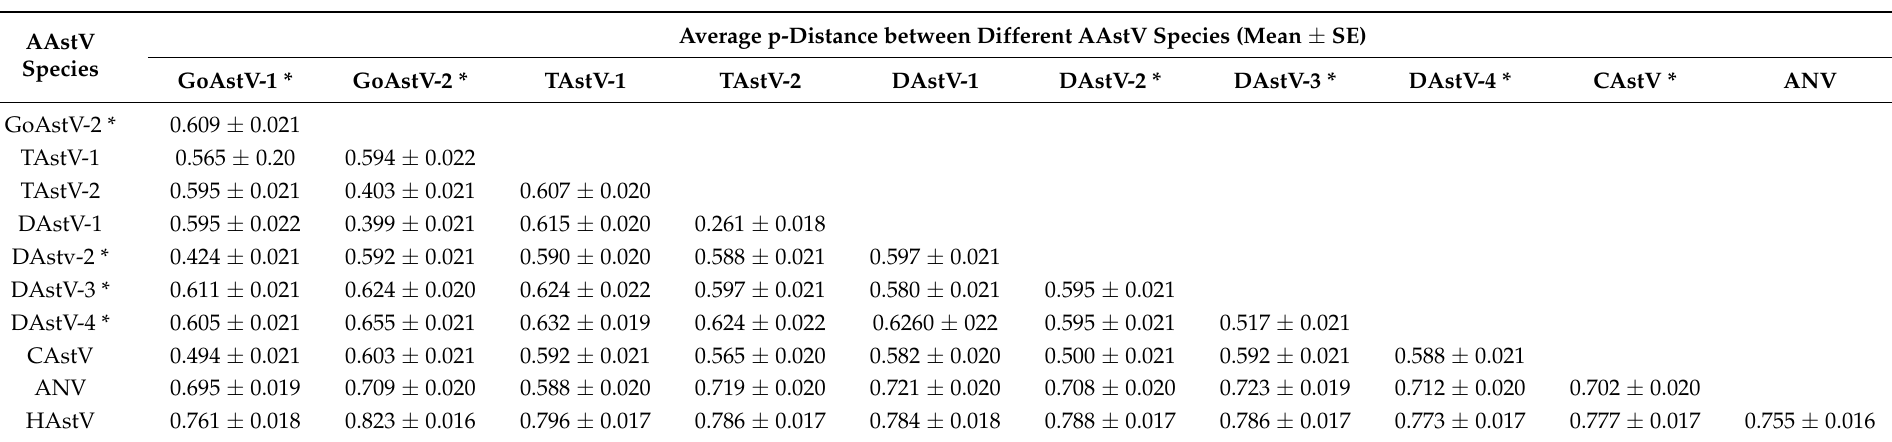
Table 3. The genetic distances (p-distance) between different AAstV species based on the complete amino acid sequences of the Cap